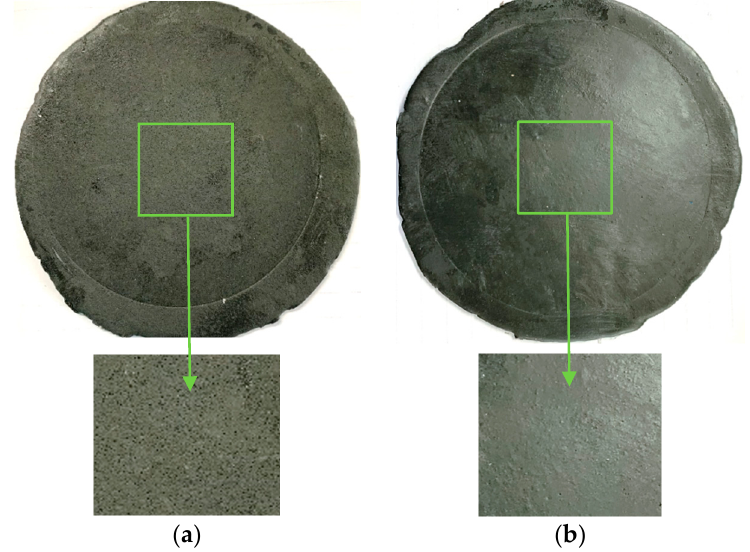
Figure 7. Impermeability test of ( a ) coating No. 19 and ( b ) coating No. 25.